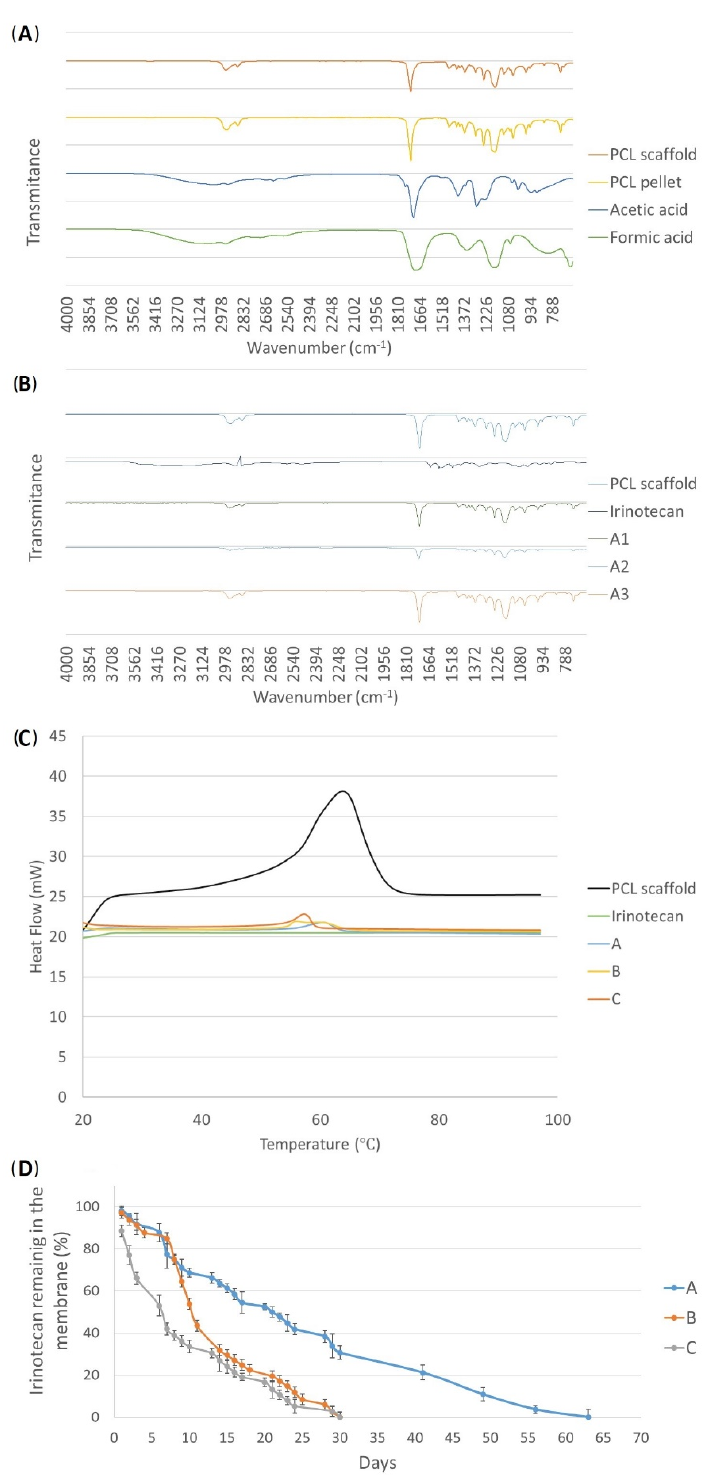
Figure 2. ( A ) Infrared spectrum (FTIR) of the solvents, PCL pellet, and the desiccated PCL scaffold. ( B ) FTIR analysis of the three different “A” type membranes with the different electrospinning parameter configurations, together with the free drug irinotecan and a pure PCL membrane. ( C ) Heat flow curve (DSC) of different membranes (pure PCL and the three solution combinations containing the drug ( A – C ) and free irinotecan. ( D ) Release profiles of the electrospun irinotecan membranes according to the manufacturing configurations measured by the spectrophotometer: ( A ) late release; ( B ) medium release; and ( C ) early release.